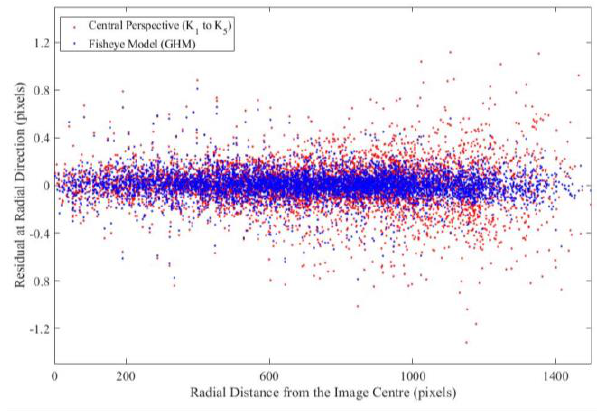
Figure 7. Ladybug image residual absolute magnitudes in the radial direction between the central perspective model and fisheye GHM. Figure 9. Principal distances of Cameras in Ladybug5 multi- a